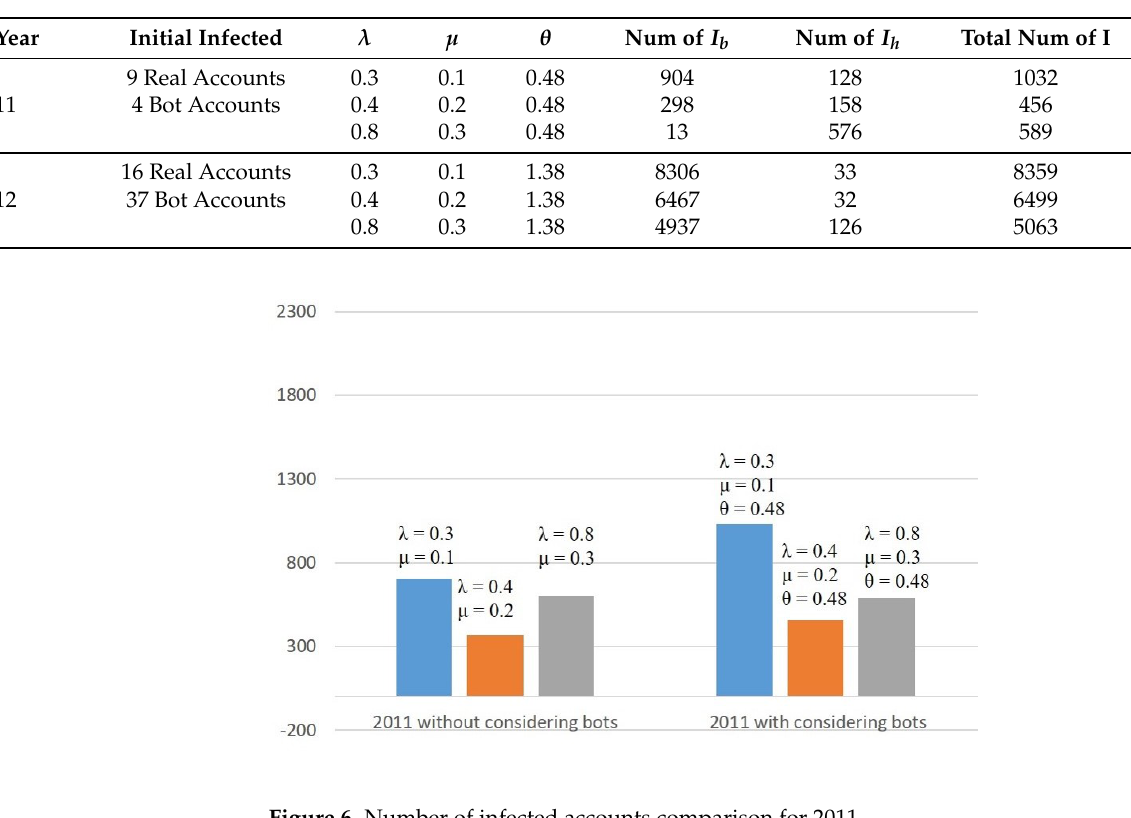
Figure 6. Number of infected accounts comparison for 2011.